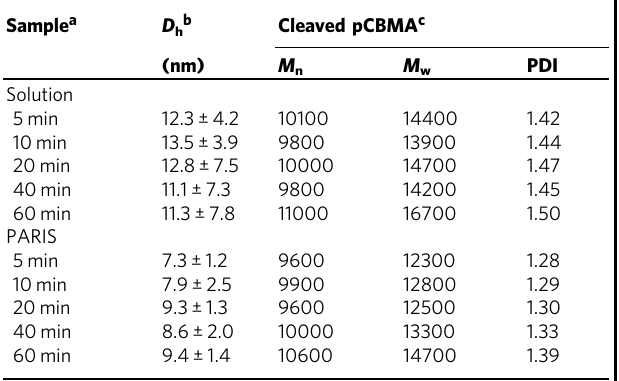
Table 3 PARIS and solution-based conjugate ATRP kinetics Sample a